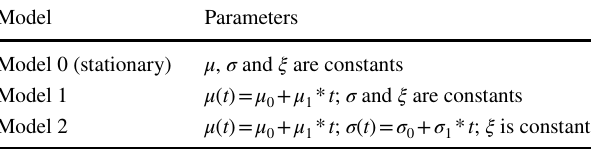
Table 2 Different combinations and the regression function Model Parameters Model 0